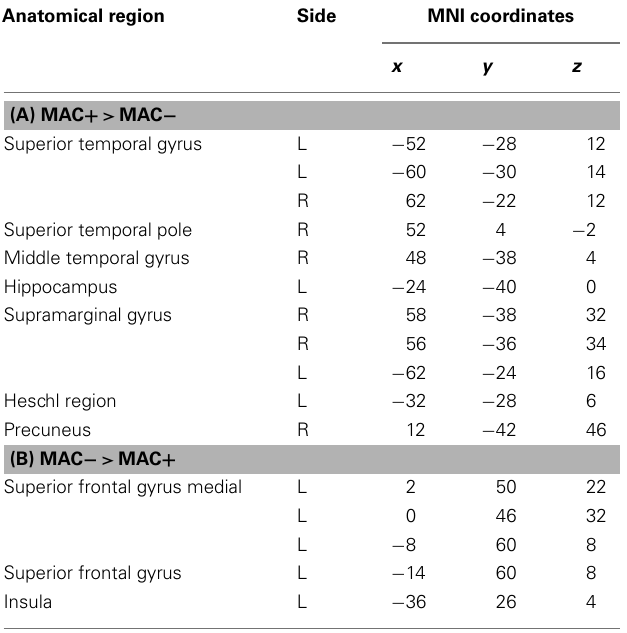
Table 7 | (A,B) Group activations for the contrast between MAC + versus MAC − (memory accuracy), p < 0.001, uncorrected.